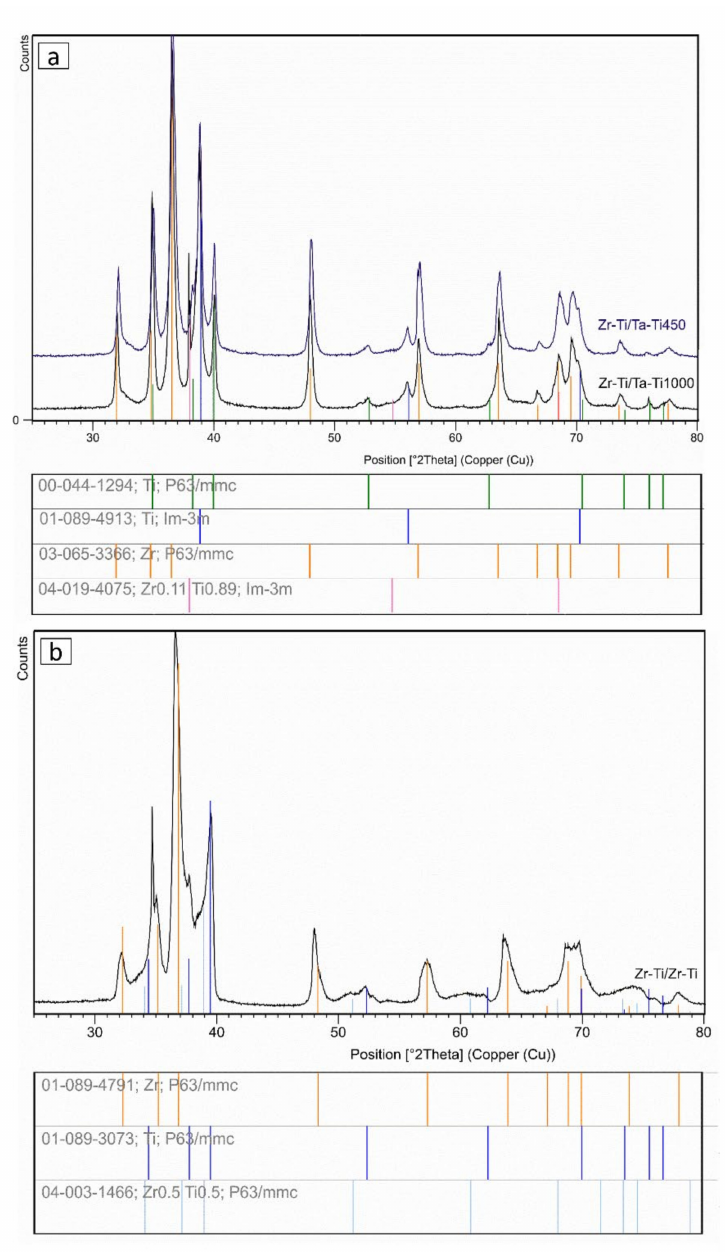
Figure 2. X-ray diffraction patterns of: ( a ) Zr–Ti/Ta–Ti system; and ( b ) Zr–Ti/Zr–Ti system. Observation of all samples at lower magnification demonstrated differences between samples with transition zone between Ti-50Ta wt.% and Ti-50Zr wt.%. In the samples containing tantalum, more distinct transition zones could be distinguished. Additionally, observation revealed, for all samples, a continuous and gradual change in microstructure. However, it is clear that all the samples had three areas. Observations at higher magnification indicated that the microstructure changed in a manner dependent on the distance from center of the sample (Figure 3). For all samples, the center was zircon with the same gradation and, therefore, for all samples, this part revealed a microstructure characteristic of zircon, with similar pore structure. The transition zone in all samples revealed a transitional and continuous change in the